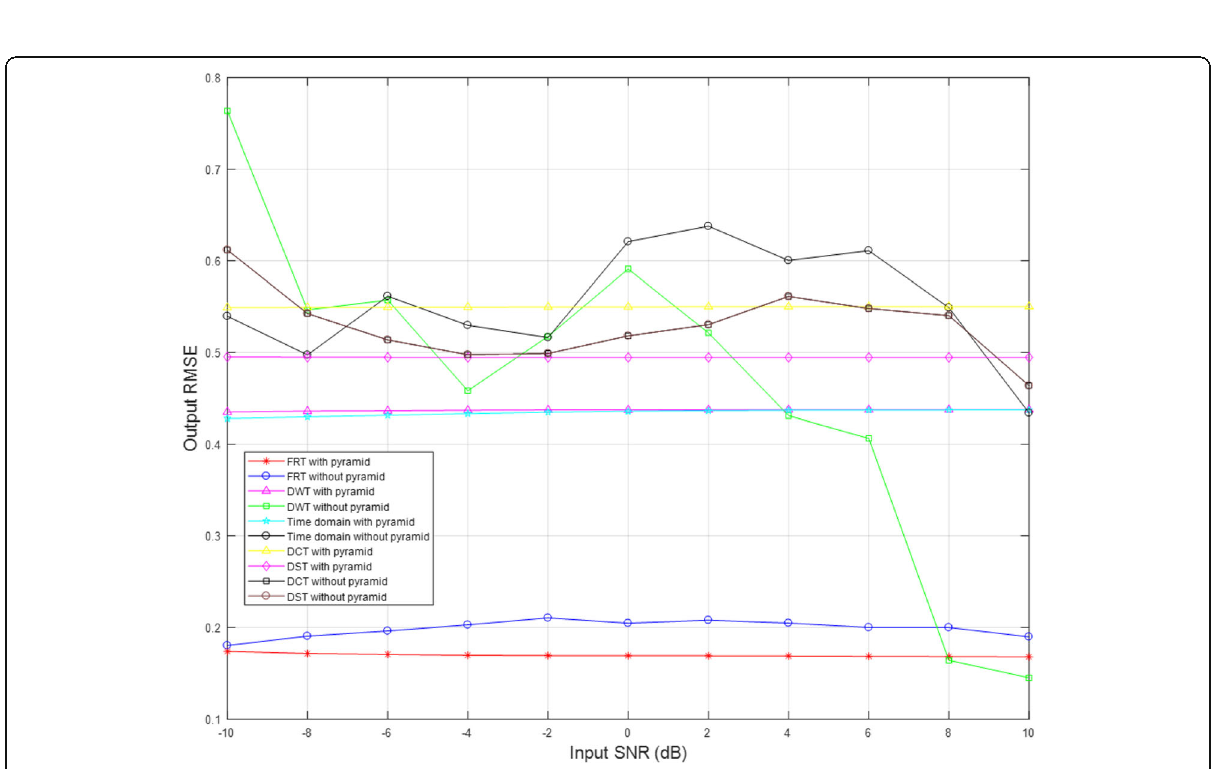
Fig. 16 Output RMSE vs. input SNR for Baboon image overall separation